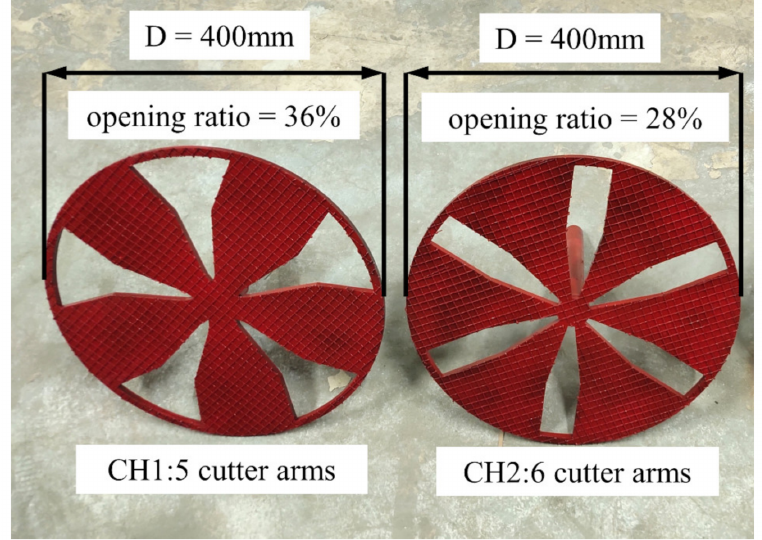
Figure 8. Two types of cutter